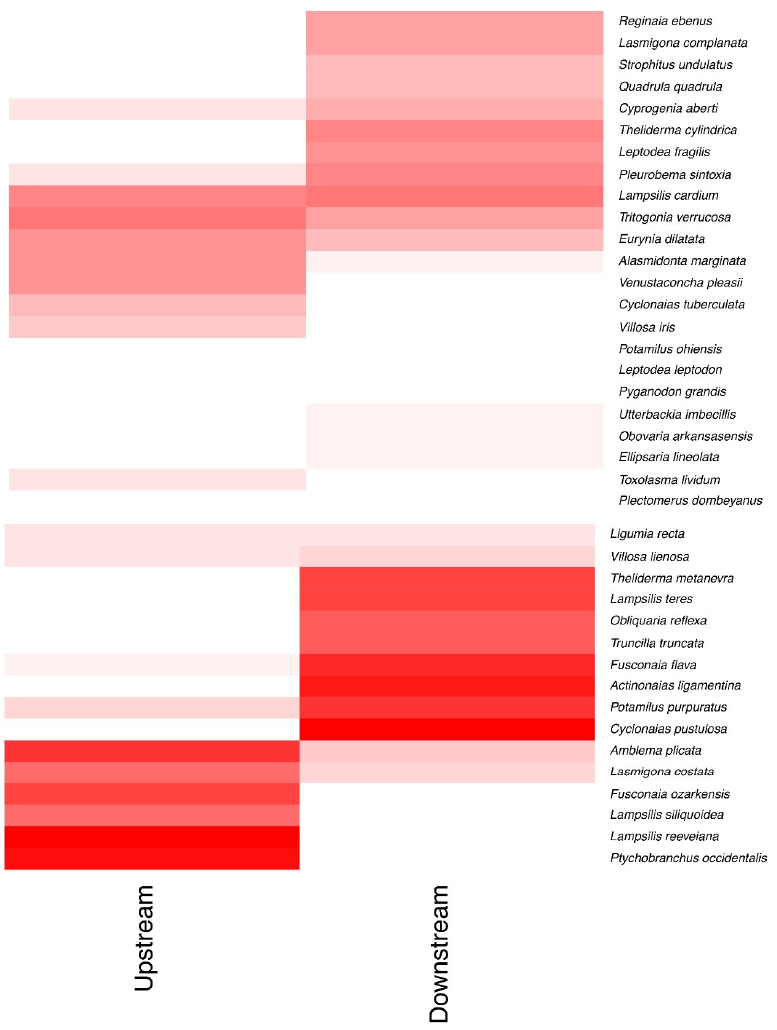
Figure 3. Heat map showing results of indicator species analysis for upstream and downstream mussel assemblage groups in the Strawberry River. Deeper red coloring indicates stronger indicator relationships within each